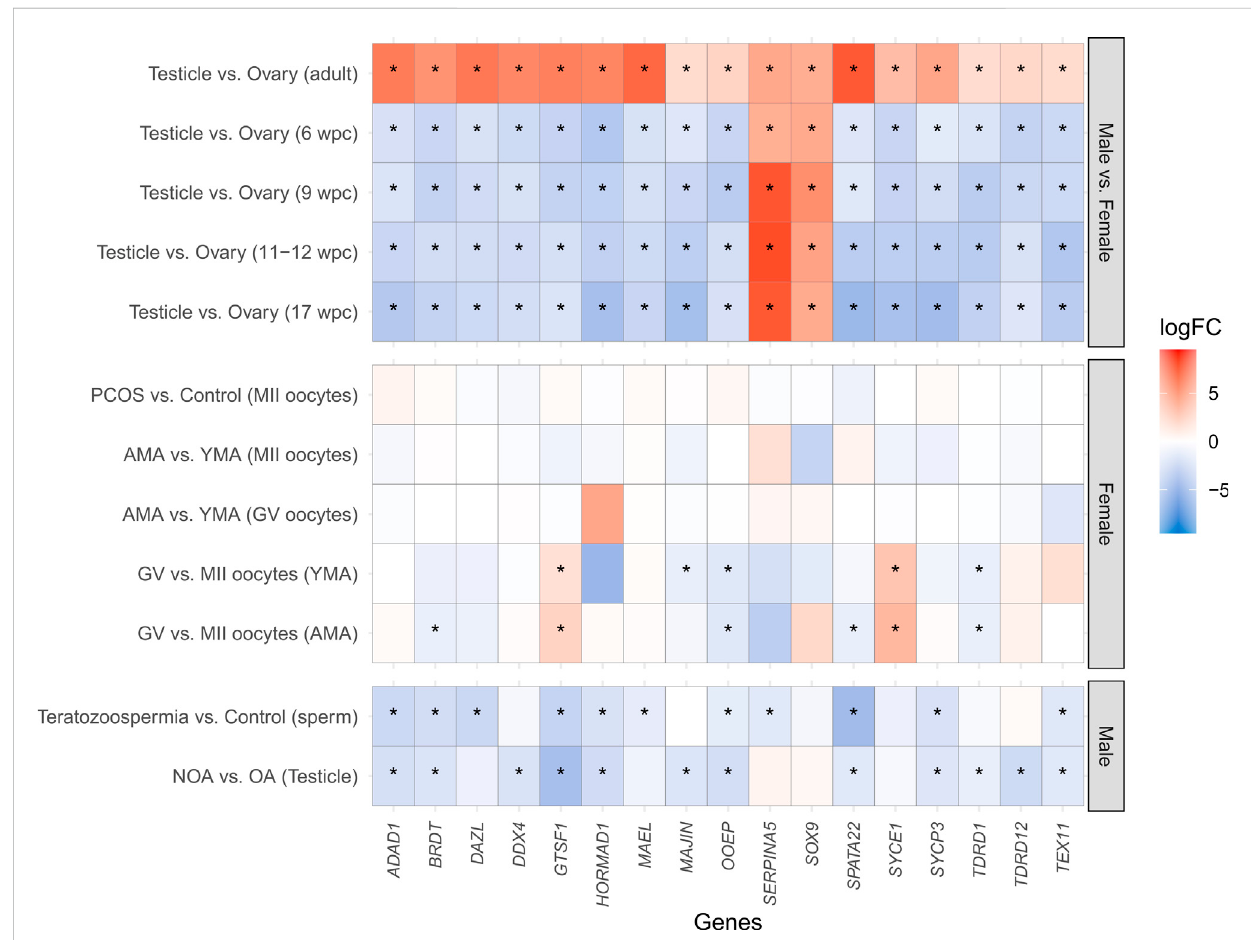
FIGURE 2 Heatmap of the differential gene expression of the 17 meiosis-related genes differentially expressed in all the developmental periods analyzed. The X -axis indicates the analyzed genes, whilst the Y -axis represents the comparisons performed. Except for SERPINA5 and SOX9 , which maintain the upregulationinthetesticleinbothprenatalandadultperiods,alltheothergenesweredownregulatedinthetesticleincomparisontotheovaryduringthe prenatal periods (6 wpc, 9 wpc, 11 – 12 wpc, and 17 wpc), and upregulated in the adulthood. No statistically signi fi cant differences were observed in MII oocytes of PCOS patients in comparison to the Control group, neither in MII and GV oocytes of AMA in comparison to YMA patients. However, when comparingGVvs.MIIoocytes,adownregulationof OOEP and TDRD1 ,aswellasanupregulationof GTSF1 and SYCE1 ,wasobservedinbothAMAandYMA patients.Adownregulationof MAJIN inGVincomparisontoMIIoocyteswasobservedonlyinYMA,andadownregulatedof BRDT and SPATA22 inAMA.A downregulation of ADAD1, BRDT, GTSF1, HORMAD1, OOEP, SPATA22, SYCP3 , and TEX11 in both teratozoospermic and NOA patients in comparison to theControlgroups.Adownregulationof DAZL , MAEL ,and SERPINA5 wasdemonstratedonlyinteratozoospermicpatients,aswellasadownregulationof DDX4 , MAJIN , TDRD1 , and TDRD12 in NOA patients, in comparison to the Control groups. wpc (weeks post-conception); PCOS (Polycystic Ovary Syndrome); AMA (advanced maternal age); YMA (young maternal age); GV (germinal vesicle); MII (mature oocytes at metaphase II stage); NOA (non- obstructive azoospermia – impaired spermatogenesis); OA (obstructive azoospermia – normal spermatogenesis); logFC (Log 2 Fold Change); * means statistically signi fi cant differences between groups (logFC ≥ |1| and adjusted p -value ≤ 0.05). Warm colors (red) represent upregulated genes, whilst cool colors (blue) downregulated